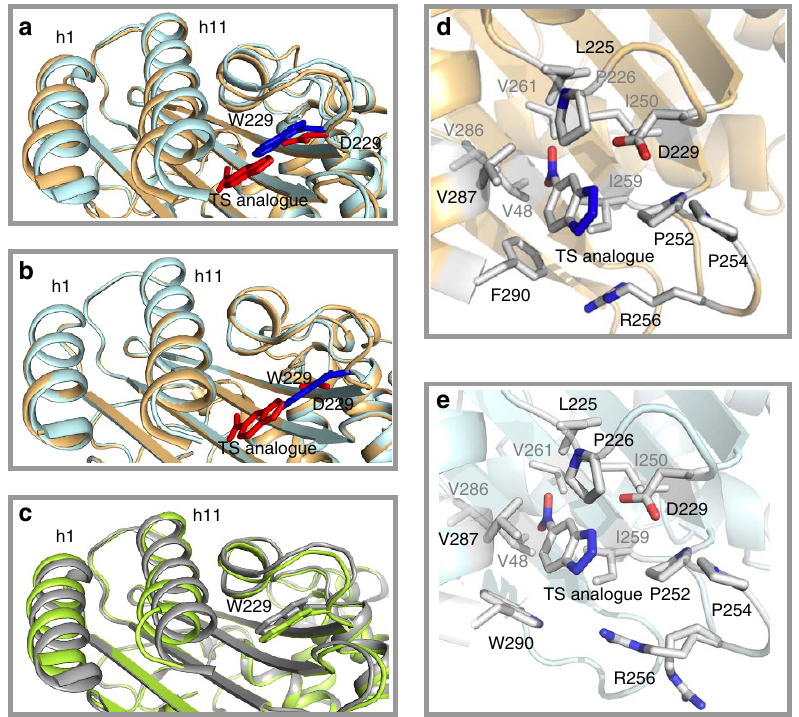
Figure 4 | 3D-structures of the de novo Kemp eliminases. ( a , b ) Shown here are the structures of the W229D variant of GNCA MP b -lactamase and the W229D/F290W variant of GNCA 4 b -lactamase, respectively. In both cases, the structures with 5(6)-nitrobenzotriazole, a transition-state analogue, bound at the de novo active site (orange-coloured structures with analogue in red) are superimposed with the 3D-structures of the corresponding GNCA MP and GNCA4 backgrounds (light-blue coloured structures with W229 in darker blue). The shift of the h1 and h11 a -helices is apparent in a , but not in b . The reason for this is that the h1 and h11 helices are already displaced in the background GNCA 4 variant, as shown by the superposition of the two backgrounds in c (GNCA MP is shown in grey and GNCA 4 is shown in light green). ( d , e ) blow-ups of the new active site region in the structures of the W229D variant of GNCA MP b -lactamase ( d ) and the W229D/F290W variant of GNCA 4 b -lactamase ( e ) with the bound transition-state analogue.